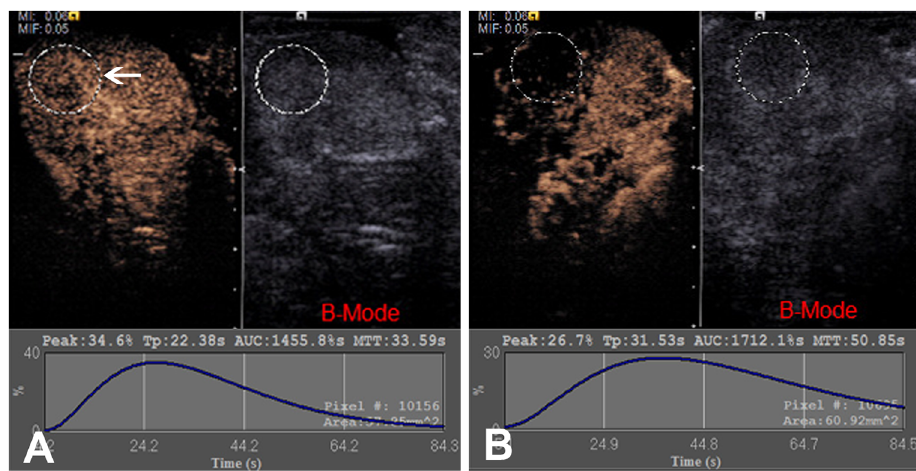
Fig 2. Analysis of the contrast-enhanced ultrasound in microbubble-enhanced ultrasound and prothrombin treated prostates. Interface of the acoustic quantification software showing the contrast- enhanced ultrasound and the 2-D images. (A) A spherical region of interest was set, and a time-intensity curve was analyzed before treatment. (B) In the microbubble-enhanced ultrasound and prothrombin groups, the curves after treatment show that the value of the peak decreased, compared with before